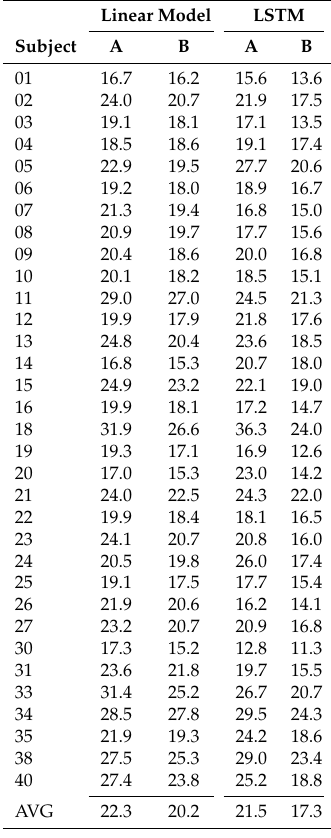
Table 8. Inter-subject RMS Error [mm] for the public dataset [26] for the case where no target subject data is used (A) and the case where 60 s of target subject standing data is used to improve pre-trained models